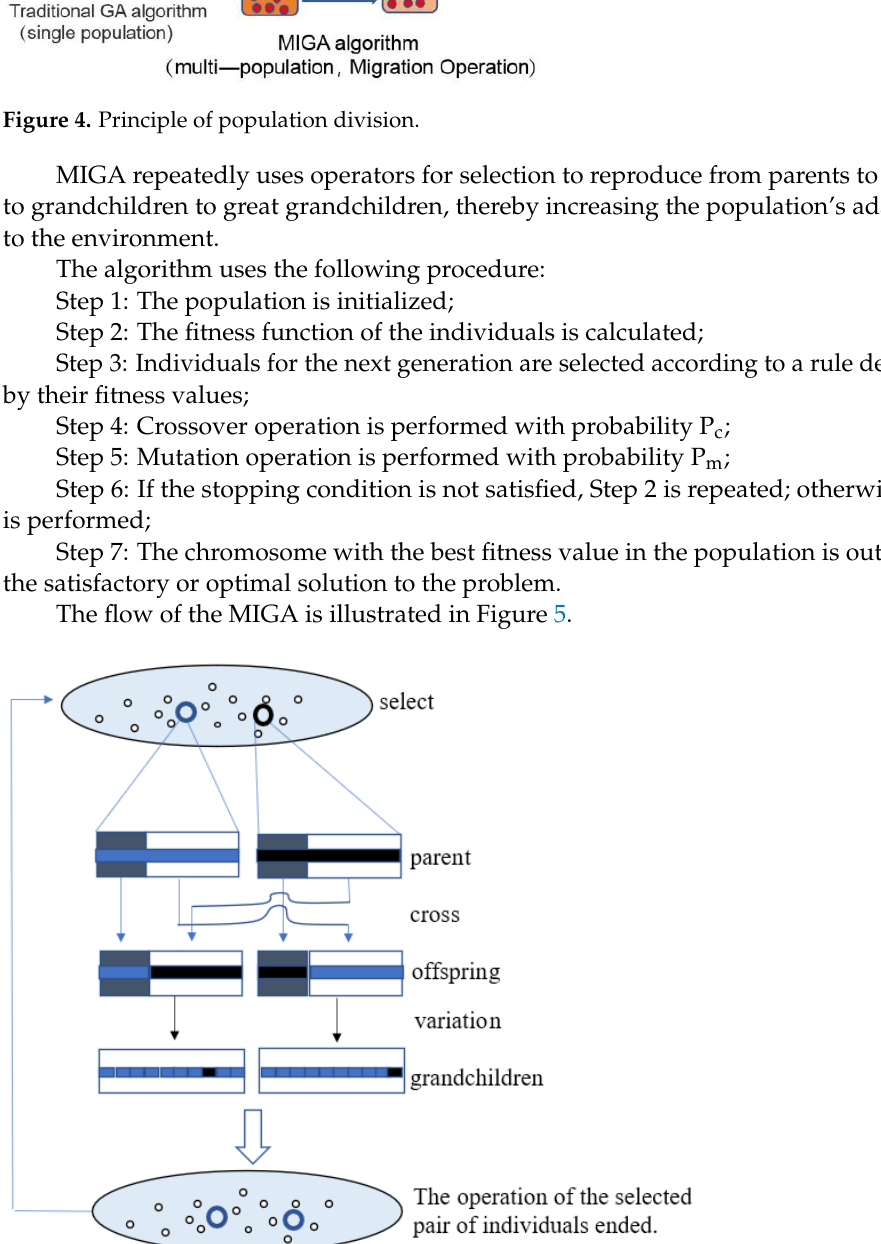
Table 2. Parameter configuration settings for MIGA. Name